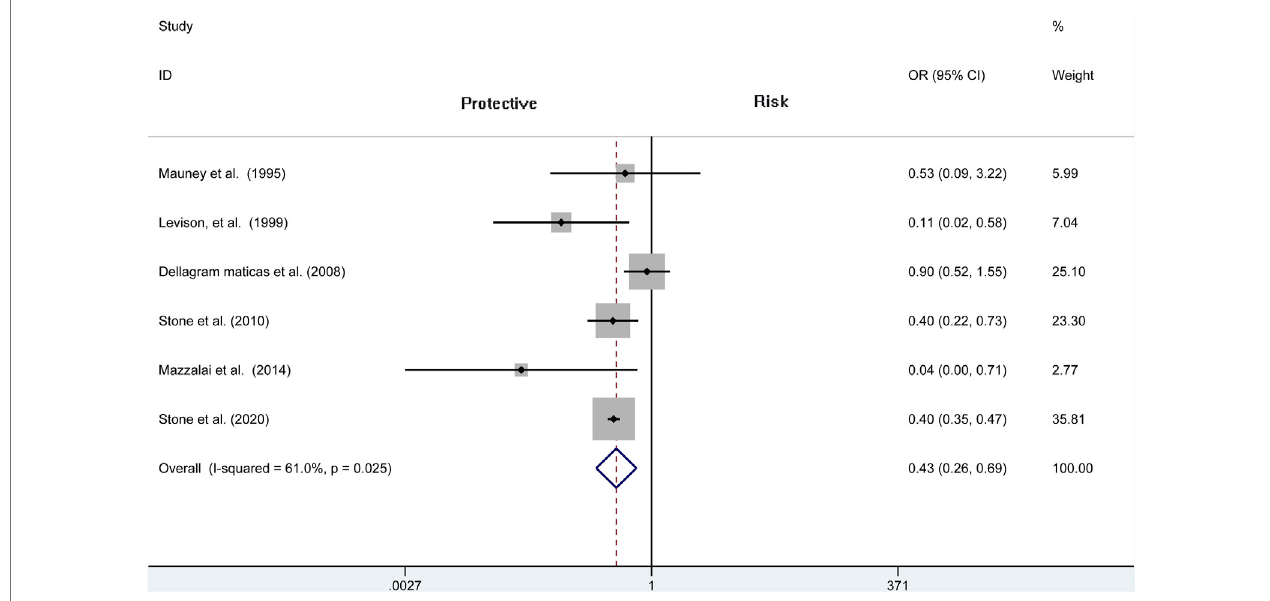
FIGURE 4 | Forest plot for meta-analysis of the incidence of hematoma requiring re-operation in the subgroup of CEA.